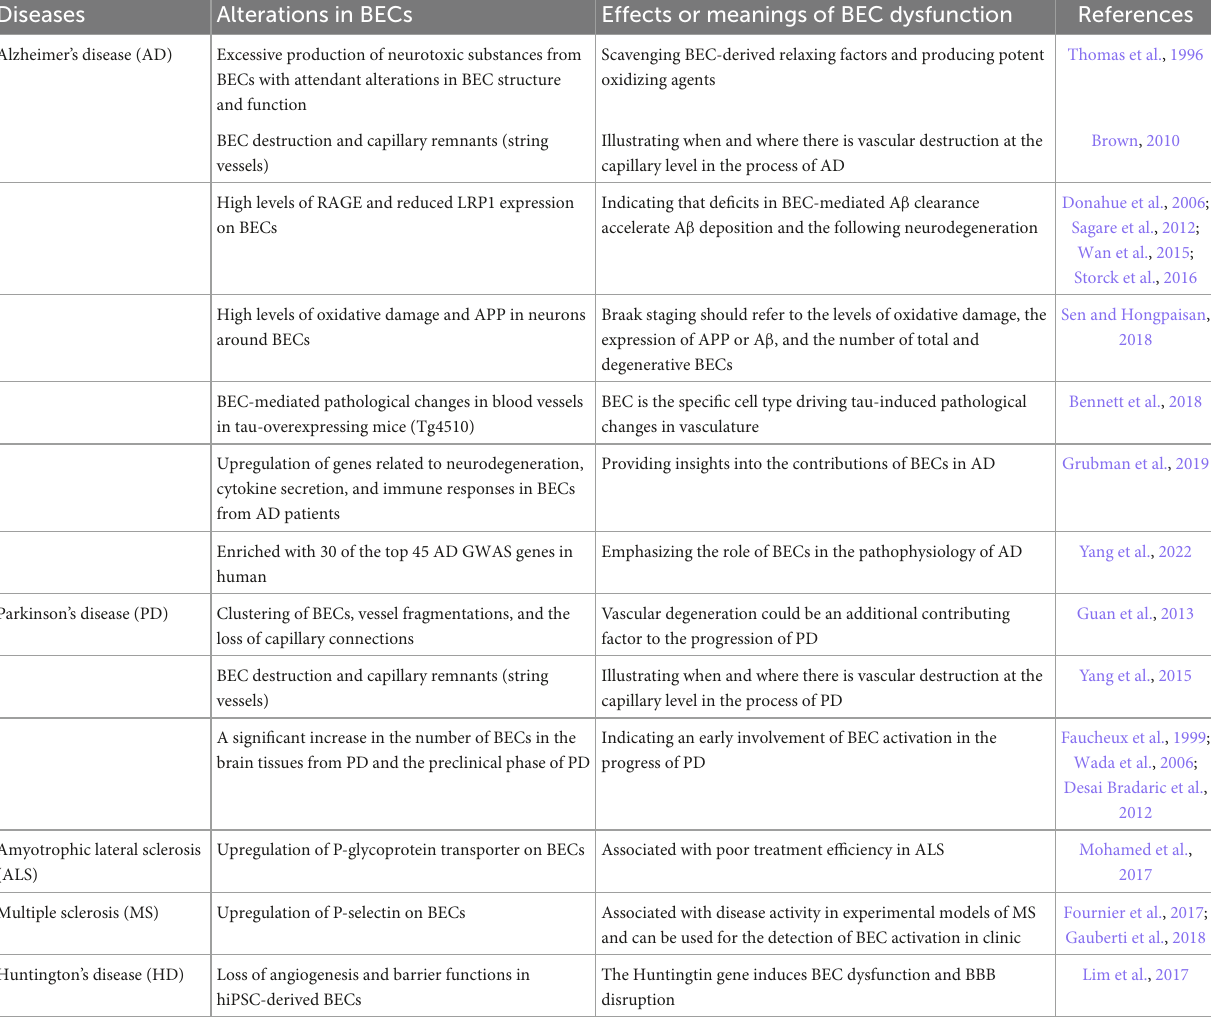
TABLE 1 Clinical and pathological evidence highlights BEC dysfunction in neurodegenerative